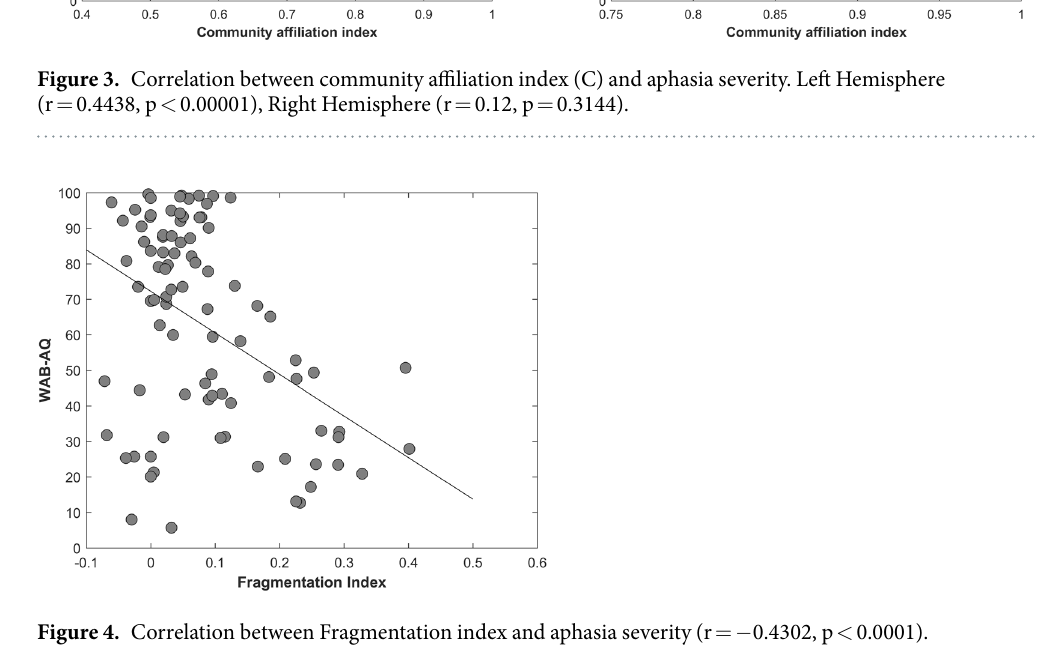
6 Scientific RepoRts | 7: 8188 | DOI:10.1038/s41598-017-07607-9